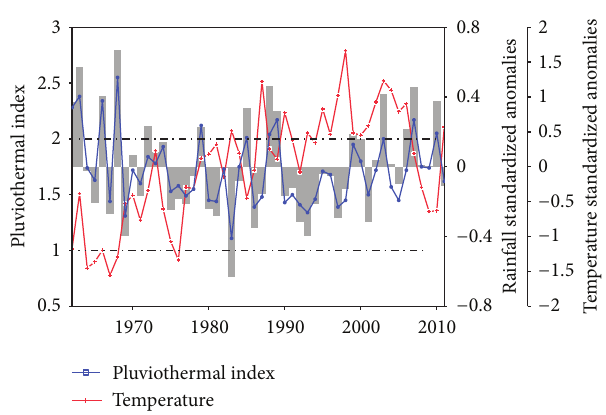
Figure 2: Annual pluviothermal index (blue curve), the annual standardized anomalies of rainfall (histogram) and of temperature (red curve) calculated as departures to the climatology during 1962– 2011. Horizontal dashed lines represent the limits for which Lamto could be localized in the arid ( 𝐼 𝑎 < 1 ), subhumid ( 1 < 𝐼 𝑎 ≤ 2 ), or humid ( 2 < 𝐼 𝑎 ≤ 3 )